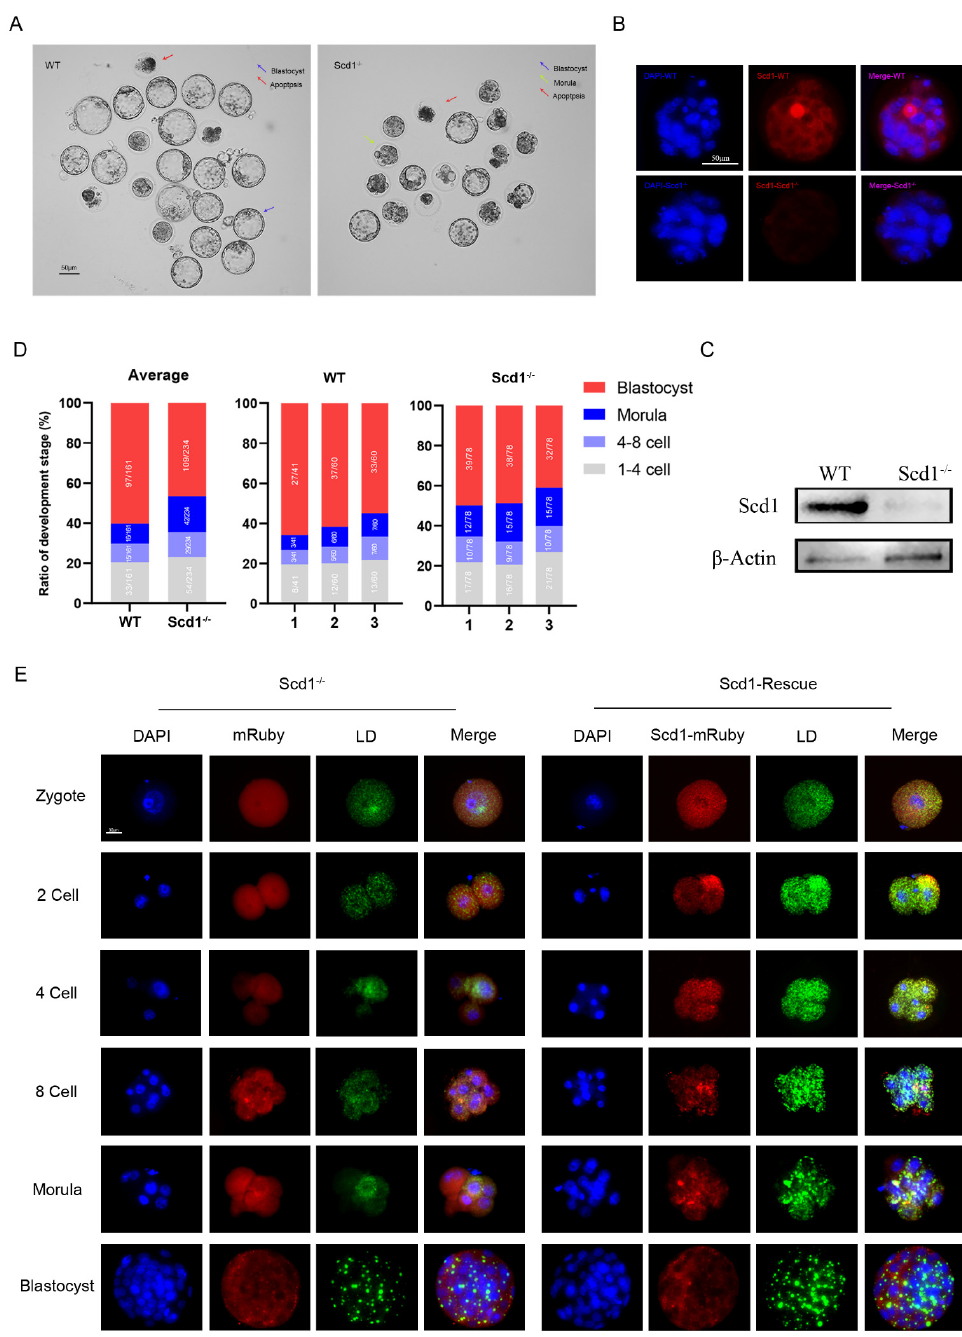
Figure 3. Scd1 regulates the blastocyst generation and lipid droplet synthesis in mouse embryos. ( A ): The comparation of blastocyst development rate between the WT and Scd1 − / − groups. Bar, 50 µ m. ( B ): Immunofluorescence staining of Scd1 in the WT and Scd1 − / − groups, Bar, 50 µ m. ( C ): the western blot detection of Scd1 in the WT and Scd1 − / − groups. ( D ): Statistics of embryo development in two groups. Data represent means of all embryos acquired from three independent culture units (1: indicates unit 1; 2: indicates unit 2 and 3: indicates unit 3). ( E ): Bodipy staining (green: refers to the lipid droplet) of Scd1 − / − embryos with or without Scd1-mRuby (rad) rescue. Bar, 30 μ m.